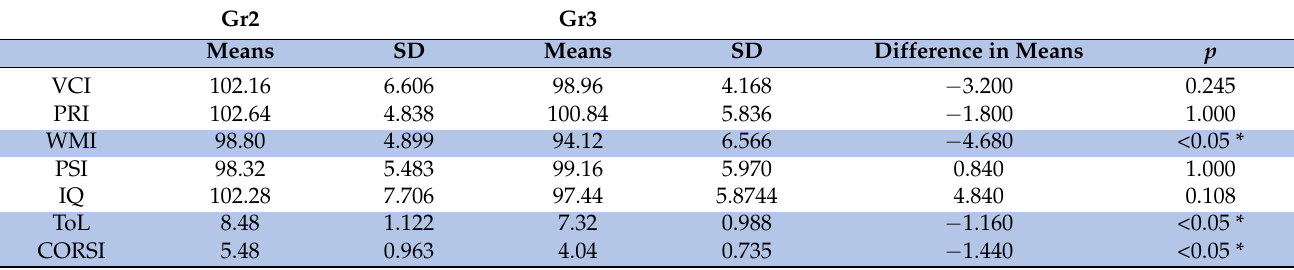
Table 4. Post hoc between Gr2 and Gr3.